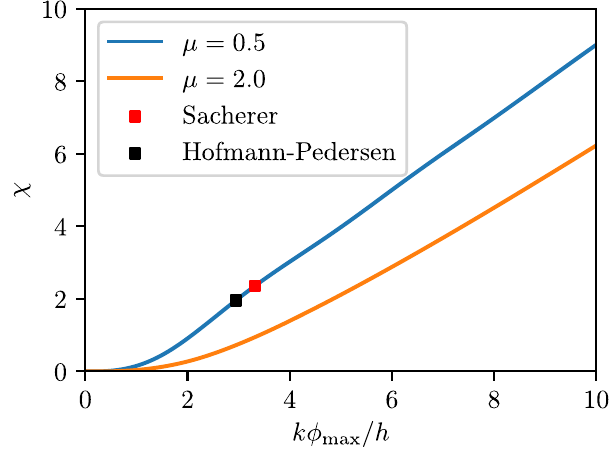
=h; μ Þ defined by max =h for which the LLD max